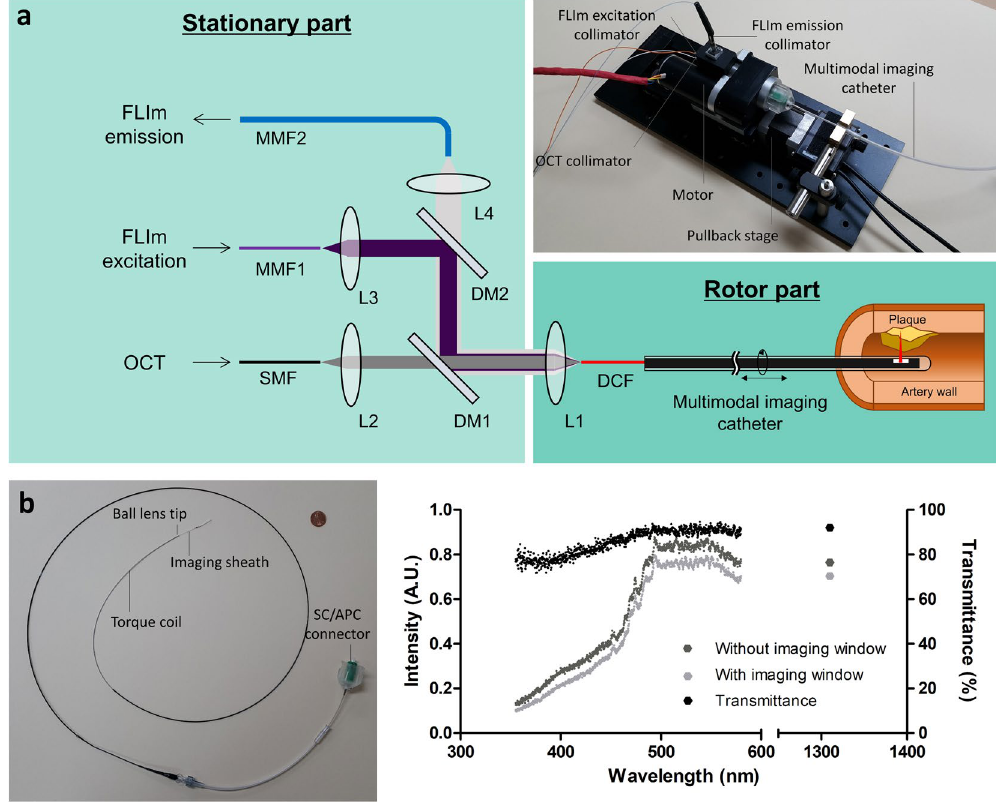
Figure 2. Optical rotary joint (ORJ) and multimodal imaging catheter. ( a ) Schematic diagram and photograph of ORJ. L, lens; DM, dichroic mirror; SMF, single-mode fiber; MMF, multi-mode fiber; DCF, double-clad fiber. ( b ) Photograph of multimodal imaging catheter with a 1 cent coin. The outer diameter of the imaging sheath is 1.04 mm. ( c ) Intensity plot without (dark gray) and with (gray) imaging window and transmittance plot (black) of imaging window. Transmittance of imaging window is more than 75% at OCT and FLIm